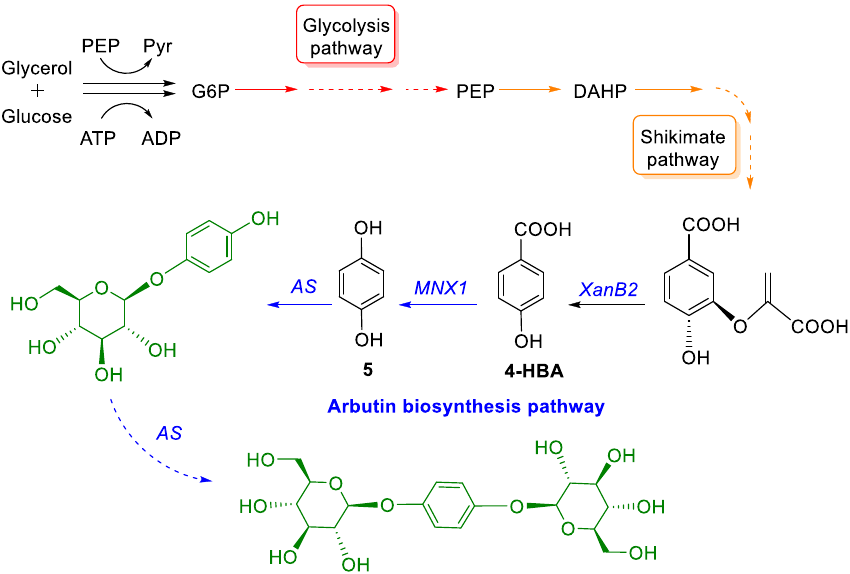
Figure 3. A schematic representation of modular engineering approaches for arbutin biosynthesis in P.chlororaphis P3.G6P, glucose 6-phosphate; PEP, phosphoenolpyruvate; DAHP, 3-deoxy- D -arabino-